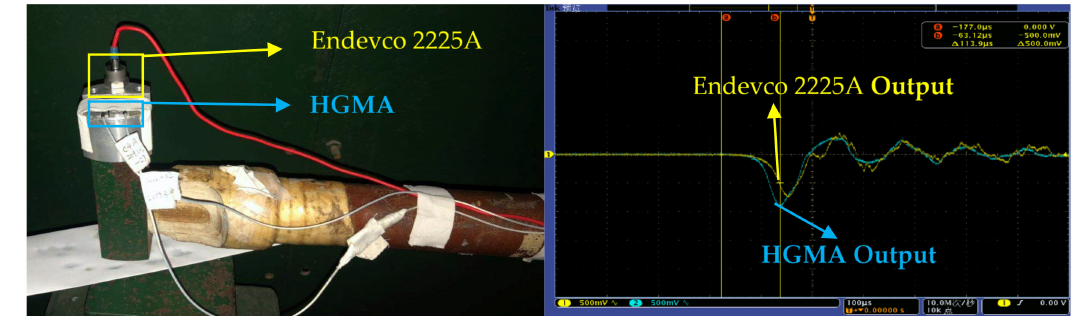
Figure 14. Endevco 2225A reference and calibration result